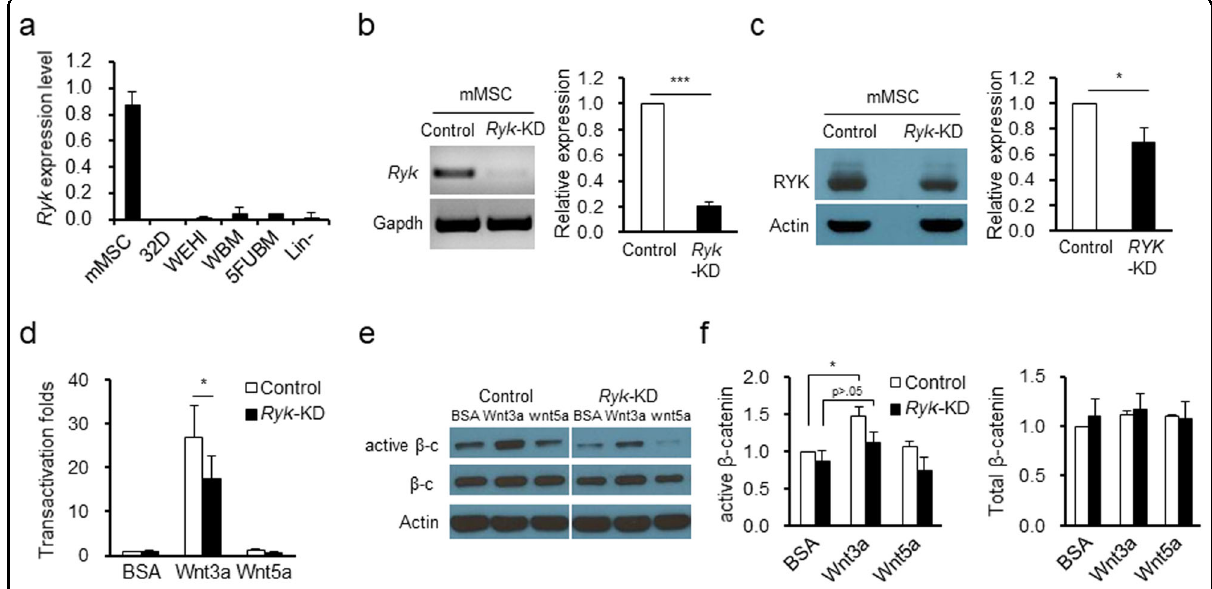
Fig. 1 Ryk is preferentially expressed in the stromal compartment to modulate Wnt signaling. a Comparison of the expression of Ryk in hematopoietic and stromal cells. The expression levels of Ryk in each indicated cell type, as determined by RQ-PCR normalized to Gapdh , are shown. mMSC: murine mesenchymal stromal cells, WBM: whole bone marrow cells, 5FUBM: 5-FU bone marrow cells, Lin-: lineage depleted hematopoietic progenitor cells. b , c Knockdown of Ryk in mMSCs. mMSCs were infected with lentiviral vector harboring shRNA- Ryk ( Ryk -KD) or shRNA-nonspeci fi c (control), and a decrease in Ryk expression at the transcript level is shown by RT-PCR (left: representative gel pro fi le, right: quantitative analysis), along with a decrease in the protein levels determined by Western blot pro fi les (left: image pro fi le, right: quantitative analysis) (mean± SEM, * p < 0.05, *** p < 0.001, n = 7 for RT-PCR, n = 3 for Western blot). d Effects of Ryk -KD on transactivation of Wnt target genes. Ryk -KD or control mMSCs were transfected with a luciferase reporter for Wnt- β -catenin target genes (TOPFLASH /FOPFLASH) to measure transactivation potential with normalization to β -galactosidase activity. The transactivation folds induced by Wnt3a or Wnt5a treatment in the control or Ryk -KD mMSCs were determined by the TOP/FOP ratio relative to that of the BSA-treated control (mean ± SEM, * p < 0.05, n = 4). e , f Effects of Ryk -KD on the accumulation of β -catenin. Ryk - KD or control mMSCs were treated with canonical (Wnt3a) or noncanonical (Wnt5a) ligands, and the levels of active (unphosphorylated) and total β -catenin were determined by Western blots and quanti fi cation by densitometry (mean ± SEM, * p < 0.05, n =